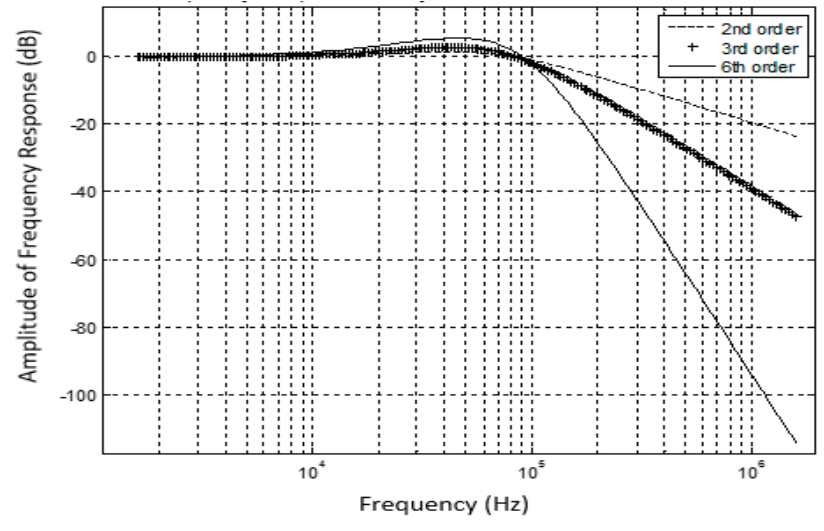
ff erent filter order and same 3-dB